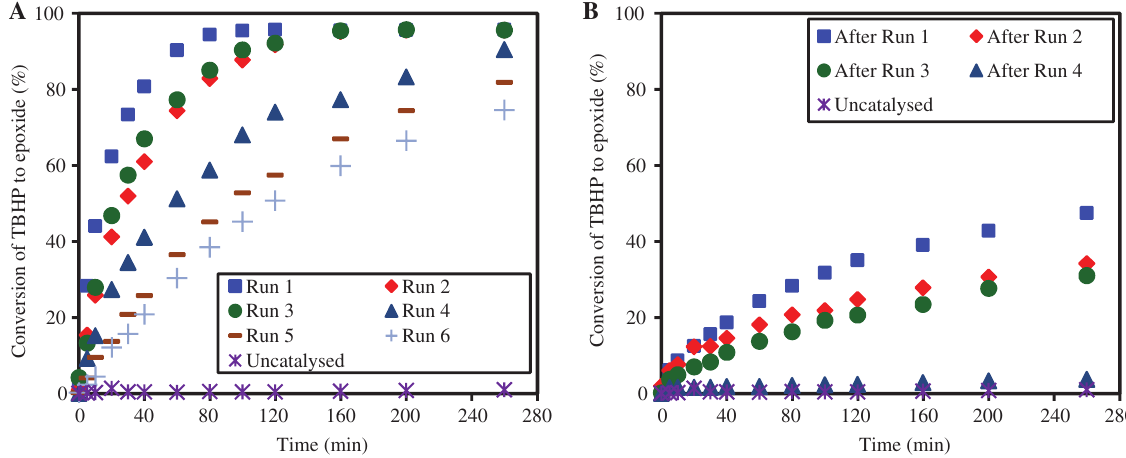
Figure 4 (A) Catalyst reusability studies of polystyrene 2-(aminomethyl)pyridine supported Mo(VI) complex (Ps.AMP.Mo) catalyst for 4-vinyl-1-cyclohexane (4-VCH) epoxidation with tert -butyl hydroperoxide (TBHP) using a batch reactor at reaction temperature: 70 ° C; cata- lyst loading: 0.3 mol%; feed molar ratio (FMR) of 4-VCH to TBHP: 5:1; stirrer speed: 400 rpm; (B) supernatant studies of 4-VCH epoxidation with TBHP catalyzed by residues isolated from supernatant solutions of Ps.AMP.Mo catalyst using a batch reactor at reaction temperature: 70 ° C; FMR of 4-VCH to TBHP: 5:1; stirrer speed: 400